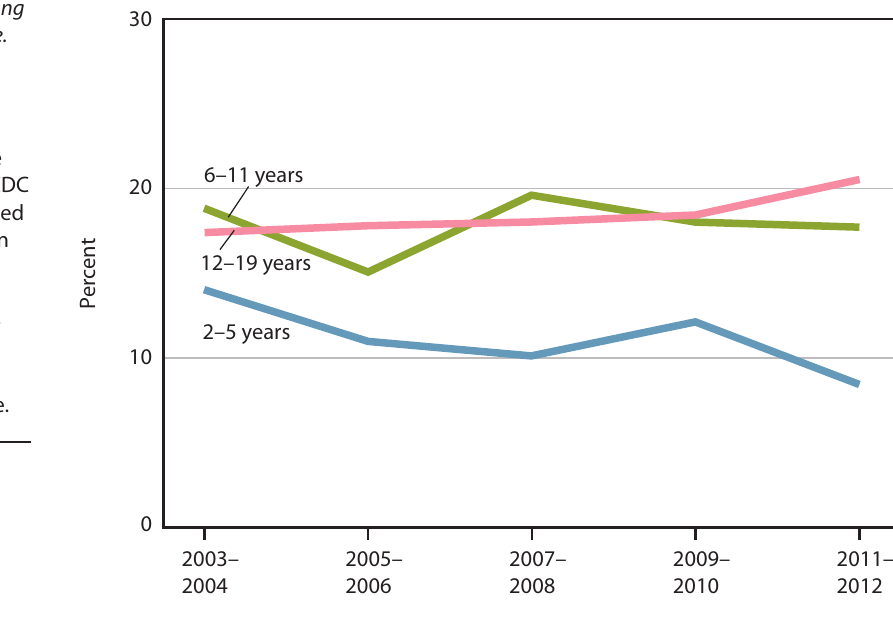
Figure 10. Obesity among children and adolescents, by age: United